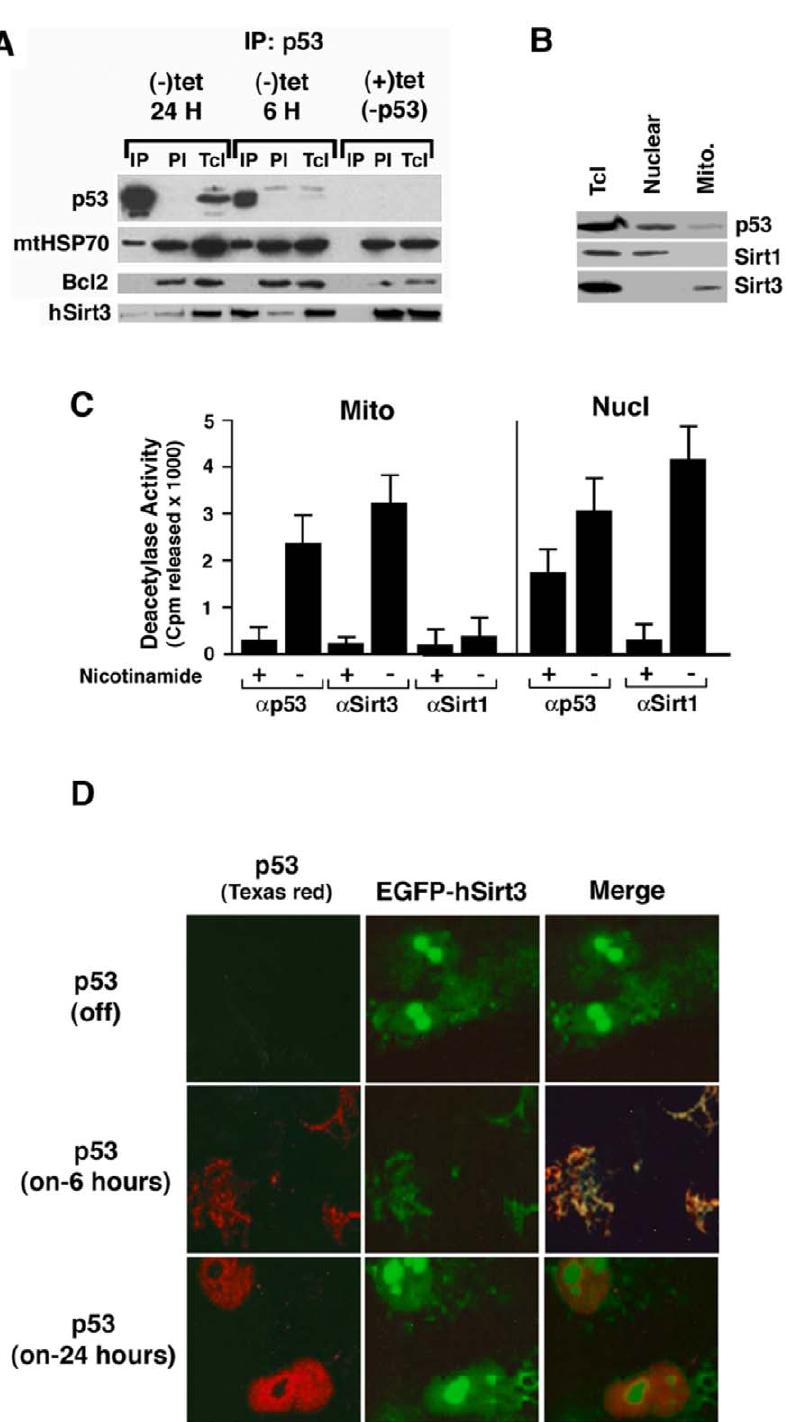
Figure 4. Association of p53 with mitochondrial proteins contains NAD + dependent protein deacetylase activity of human SirT3. ( A ). Total cell lysate from ( + )tet, (-)tet 6 h and 24 h EJ-p53 cells were collected and solubilized in lysis buffer containing complete proteolysis inhibitor. Monoclonal antibody against human p53 (DO1) and then protein G-agarose beads were added to the sample. The immunoprecipitated proteins from the washed beads were separated on a 10% gel, then transfer to filters for immunoblotting. Blots were blocked and probed with anti-p53 (mouse monoclonal DO-1), polyclonal rabbit anti-mthsp 70 (HSPA9) and mouse monoclonal anti-Bcl 2 (clone 124, Dako USA) and anti- SirT3 followed by HRP- conjugated anti-goat, HRP-conjugated anti-mouse and HRP-conjugated anti-rabbit, and then developed using ECL. ( B ). Total cell, nuclear, and mitochondrial fractions were obtained from EJ-p53 cells after 12 hours of tetracycline withdrawal and p53 expression. Each fractionated lysate was analyzed by SDS-PAGE and immunoblotted with antibodies against p53, SirT1 and SirT3. ( C ) Protein deacetylase activity was measured against a synthetic peptide corresponding to the human p53 protein sequence (HLKSKKGQSTSRHKKLMFK-C*) radiolabeled with [ 14 C]-acetylCoA (GE Healthcare) and purified acetyltransferases CBP and PCAF in vitro . Deacetylase activity was determined from mitochondrial and nuclear fractions taken from EJ-p53 cells following 12 hours after induction of p53 expression by tetracycline withdrawal. Deacetylase activity was determined from